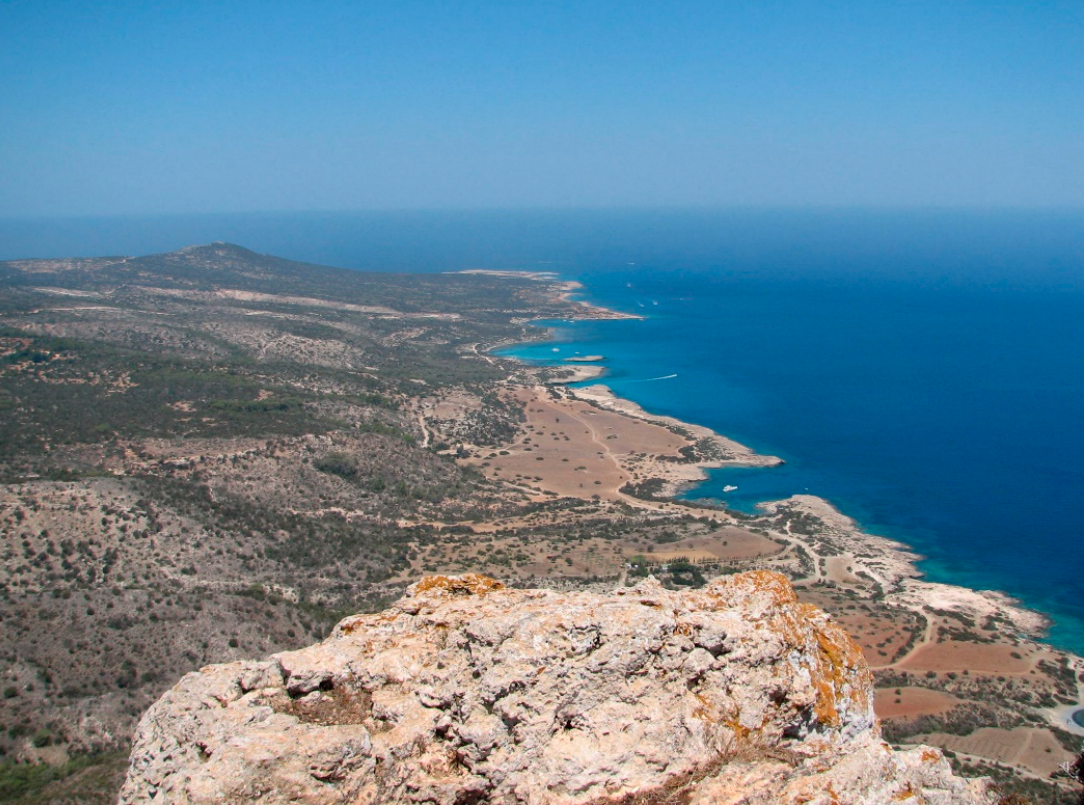
Figure 1. An “insula portuosa.” Inlets and bays along the coast of Cyprus looking towards Cape Akamas, the island’s farthest northwestern point. Photo by J.M. Gordon.